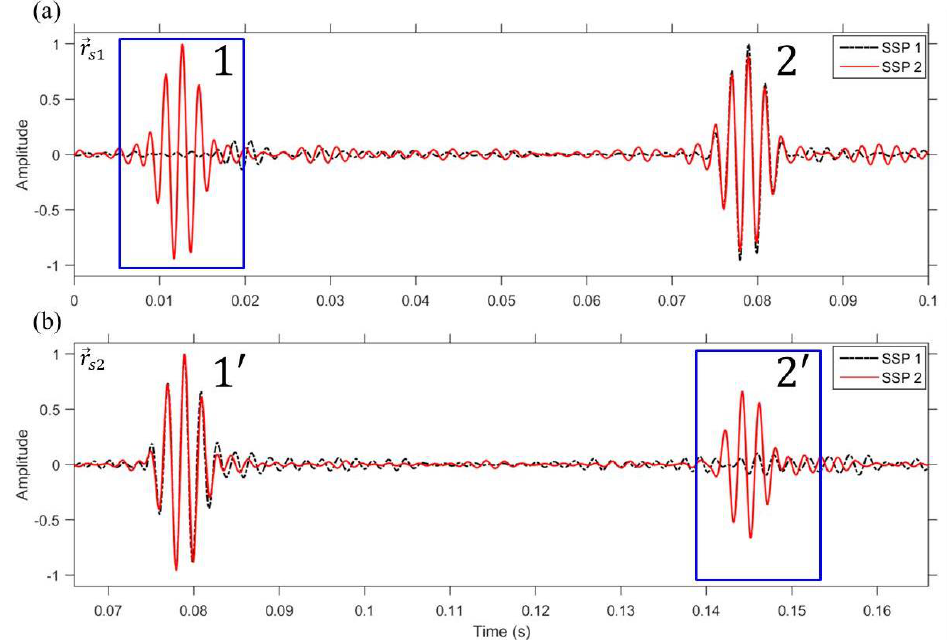
Figure 5. (Color online) Simulated adaptive VSA-based multiple TR focusing for different types of profiles. ( a ) Time series at (cid:126) r s 1 = (2.2 km, 50 m); ( b ) Time series at (cid:126) r s 2 = (2.3 km, 50 m). While pulse compression is fully achieved for the isovelocity with a sound speed of c = 1500 m/s (SSP 1, dot-dashed), the residual signal (denoted by a rectangular box) is still observable for the downward-refracting SSP (SSP 2, solid).